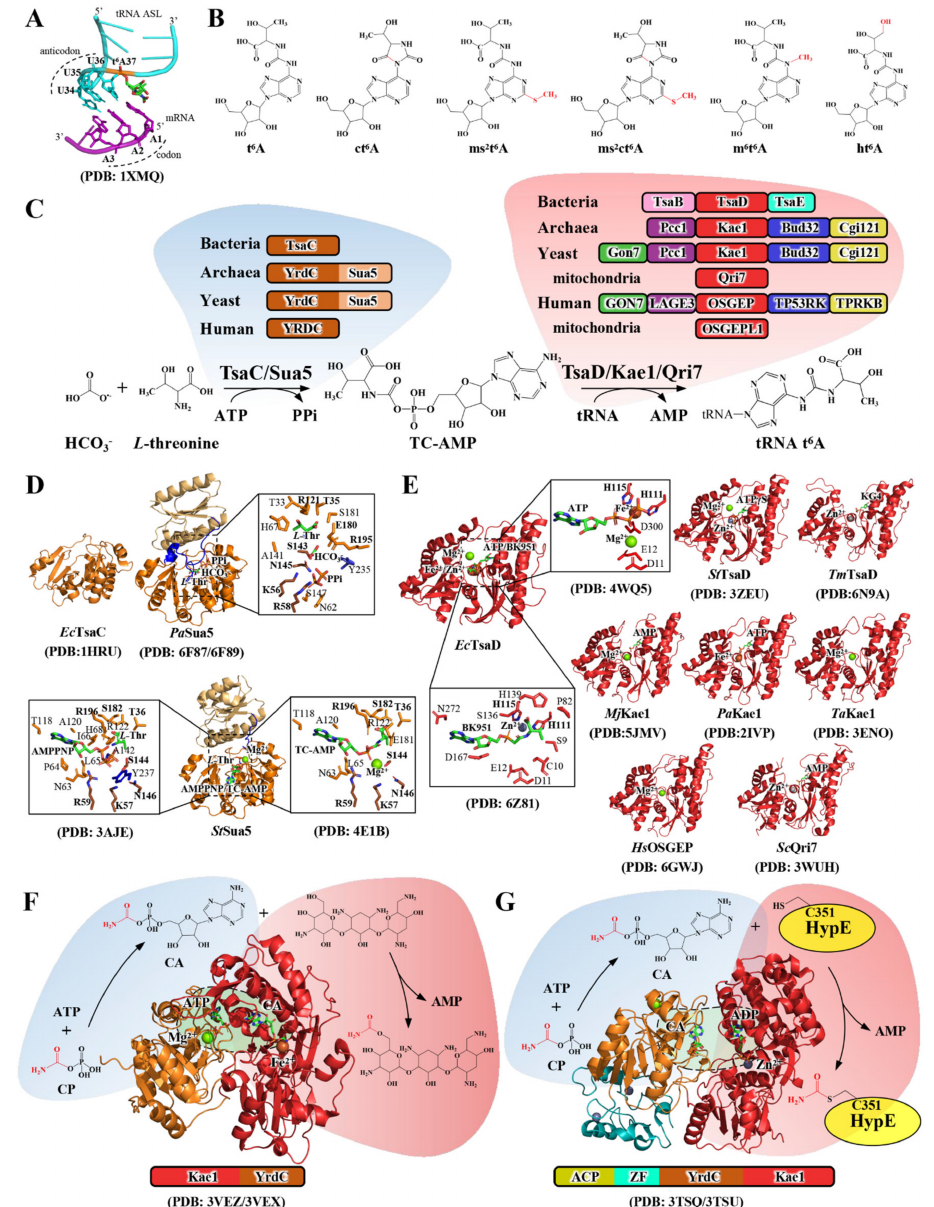
Figure 1. Structure, function and biosynthetic pathway of tRNA t 6 A. ( A ). The crystal structure of t 6 A-ASL of E coli. tRNA Lys (UUU) paired with mRNA in ribosomes (omitted for clarity) [22]. ( B ). Chemical structures of t 6 A and t 6 A derivatives with modifications highlighted in red. t 6 A, N 6 -threonylcarbamoyladenosine; ct 6 A, cyclic N 6 -threonylcarbamoyladenosine; ms 2 t 6 A, 2-methylthio- N 6 -threonylcarbamoyladenosine; ms 2 ct 6 A, 2-methylthiocyclic N 6 -threonylcarbamoyladenosine; m 6 t 6 A, N 6 -methyl- N 6 -threonylcarbamoyladenosine; ht 6 A, hydroxy- N 6 -threonylcarbamoyladenosine. ( C ). Enzymatically validated and representative tRNA t 6 A-modifying enzymes in the three domains of life and the enzymatic pathway of tRNA t 6 A biosynthesis. The catalytic members of TsaC/Sua5 and TsaD/Kae1/Qri7 families are colored in brown and red, respectively. Evolutionarily related proteins are color-coded. ( D ). Crystal structures of E. coli TsaC [31], P. abyssi Sua5 [32] and S. tokudaii